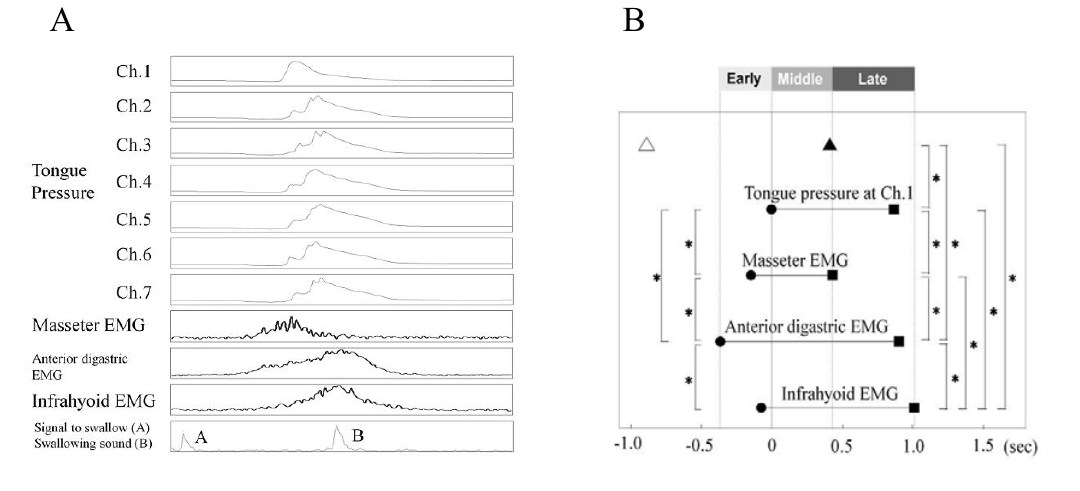
Figure 10. A: representative recording of tongue pressure at Chs. 1–7, integrated EMG of the masseter, submental, and infrahyoid muscles, signal to swallow, and swallowing sound, from which coordination of the tongue and oropharyngeal muscle activity was analyzed. B: coordination of tongue pressure produced at Ch. 1, activity of masseter, submental, and infrahyoid muscles, and swallowing sound during swallowing. The onset of tongue pressure at Ch. 1 was set to 0 seconds. △: signal to swallow; ▲ : swallowing sound; ● : onset; ■ : offset; * P < 0.05. Each timing of onset and offset was consistent with safe management of the bolus at the early, middle, and late stages of swallowing [48].